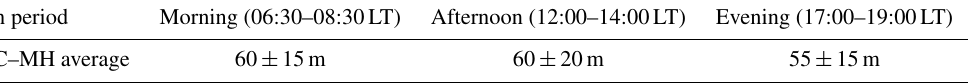
Table 6. Calculated mean MH during all morning, afternoon, and evening runs with ground temperature inversions, derived from eBC vertical mass concentration profiles ( N = 46). The MHs are rounded to 5m.